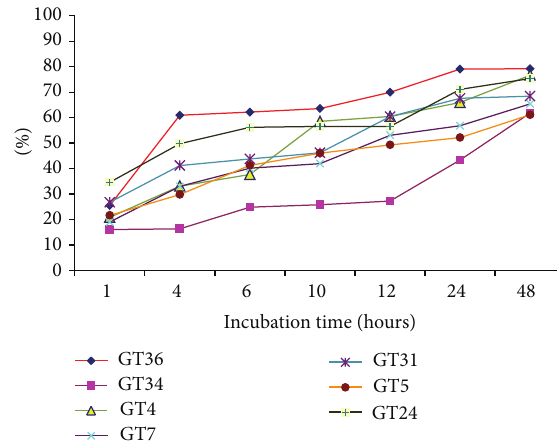
Figure 5: Germination percentage of cherry laurel genotypes over the incubation